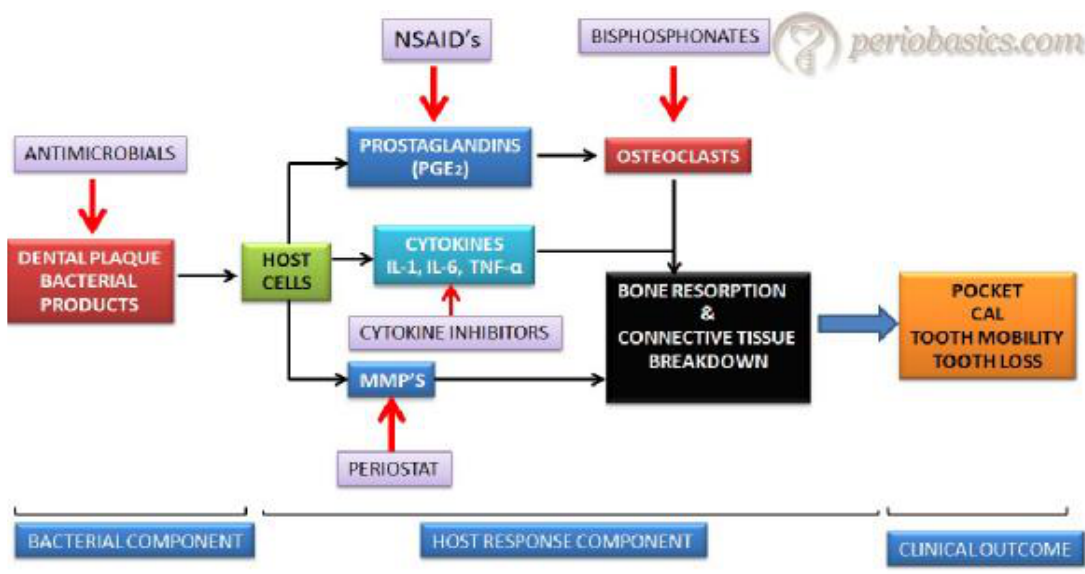
Figure2:Potential adjunctive therapeutic approaches .Possible adjunctive therapies and points of intervention in the treatment of periodontitis are presented related to the pathologic cascade of events . CAL , Clinical attachment loss